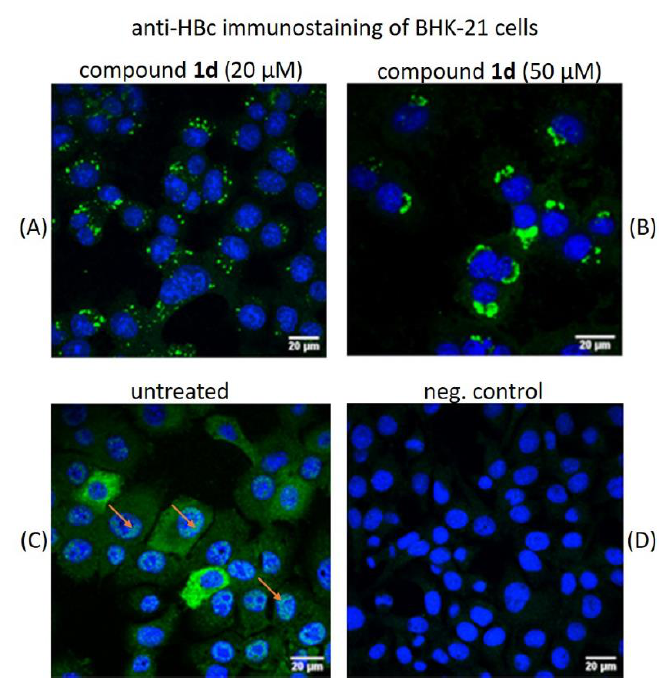
Figure 10. Immunostaining of HBc protein in BHK-21 cells after treatment with HAP compound 1d . BHK cells were infected with recombinant SFV1/HBc virus, next day the cell culture medium was replaced with comp. 1d containing medium and incubated for 24h. After incubation the anti-HBc immunostaining analysis was performed using monoclonal C1-5 antibodies (green fluorescence). The cells were analyzed by confocal microscopy and compared with untreated cells. The nuclei were stained with DAPI (blue). ( A ) cells treated with 20 µM comp. 1d . ( B ) cells treated with 50 µM comp.